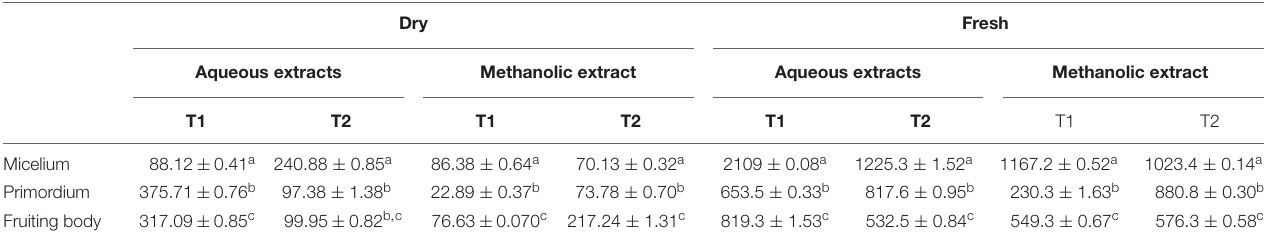
TABLE 6 | ABTS radical scavenging activity of P. ostreatus.